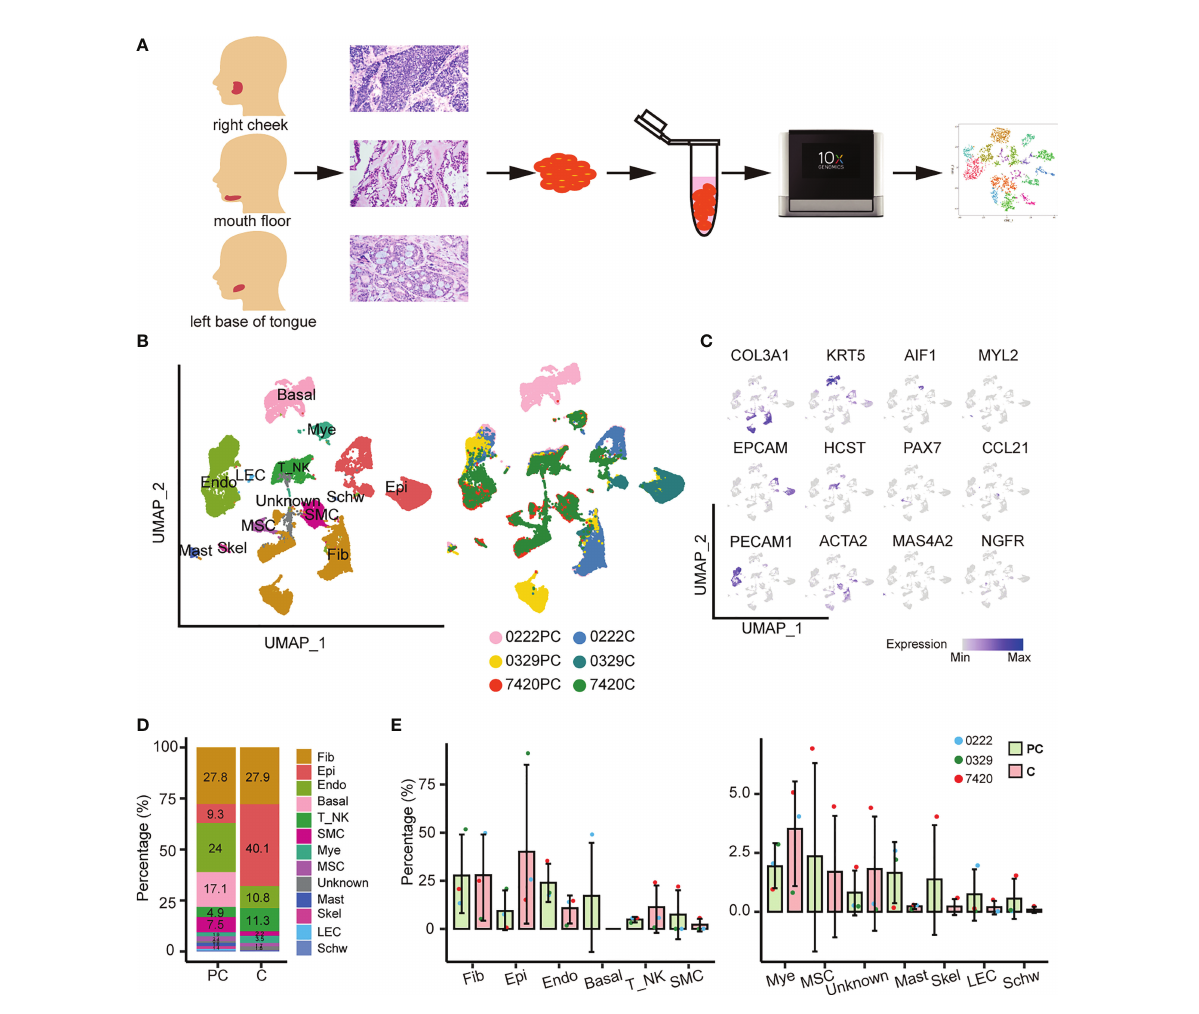
FIGURE 1 Overview of THE ACC tumor microenvironment. (A) Work fl ow for collecting clinical samples and processing scRNA-Seq data. (B) UMAP of 13 cell populations from six samples. PC, paracarcinoma; C, carcinoma. (C) Cell subtypes were labeled in the UMAP plot using typical markers. (D) The abundance of each cell population in the paracarcinoma and carcinoma tissues. (E) The relative abundance of 13 cell clusters in the paracarcinoma and carcinoma tissues. Error bars are presented as mean values ±